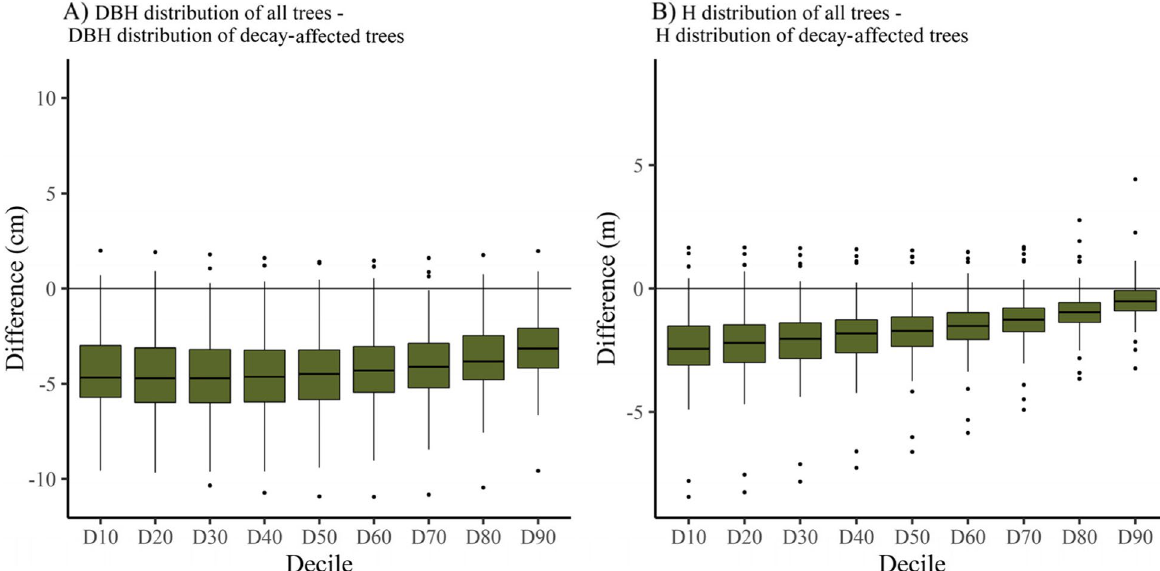
Fig. 4 Differences in decile values of 101 harvested segments between A DBH distributions of all trees and DBH distributions of decay-affected trees and between B H distributions of all trees and H distributions of decay-affected trees in the harvested segments. DBH, diameter at breast height; H,